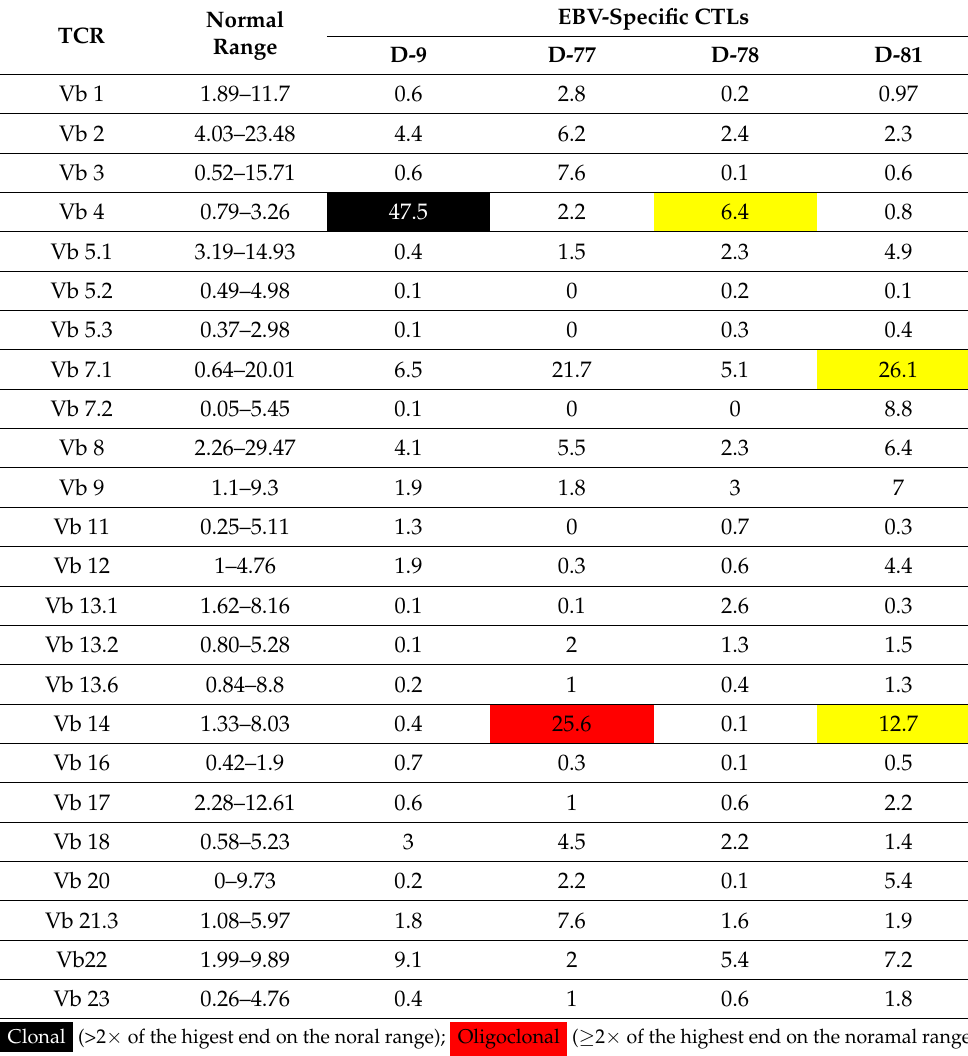
Table 1. Distribution of 24 TCR-V β families in RAK+ T-cells from 4 HLA-B8